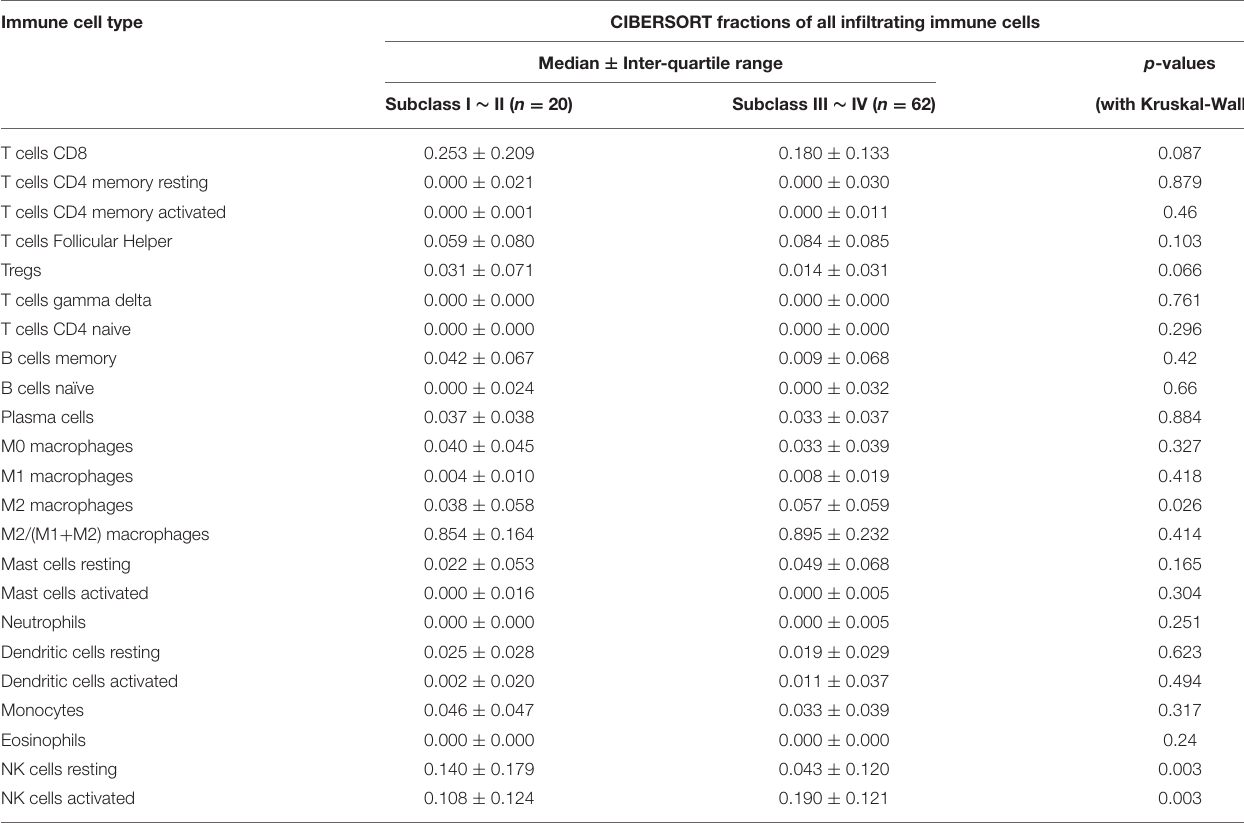
TABLE 3 | Comparison of immune cell fractions between two eutopic endometrial tissue (EU) subclasses.